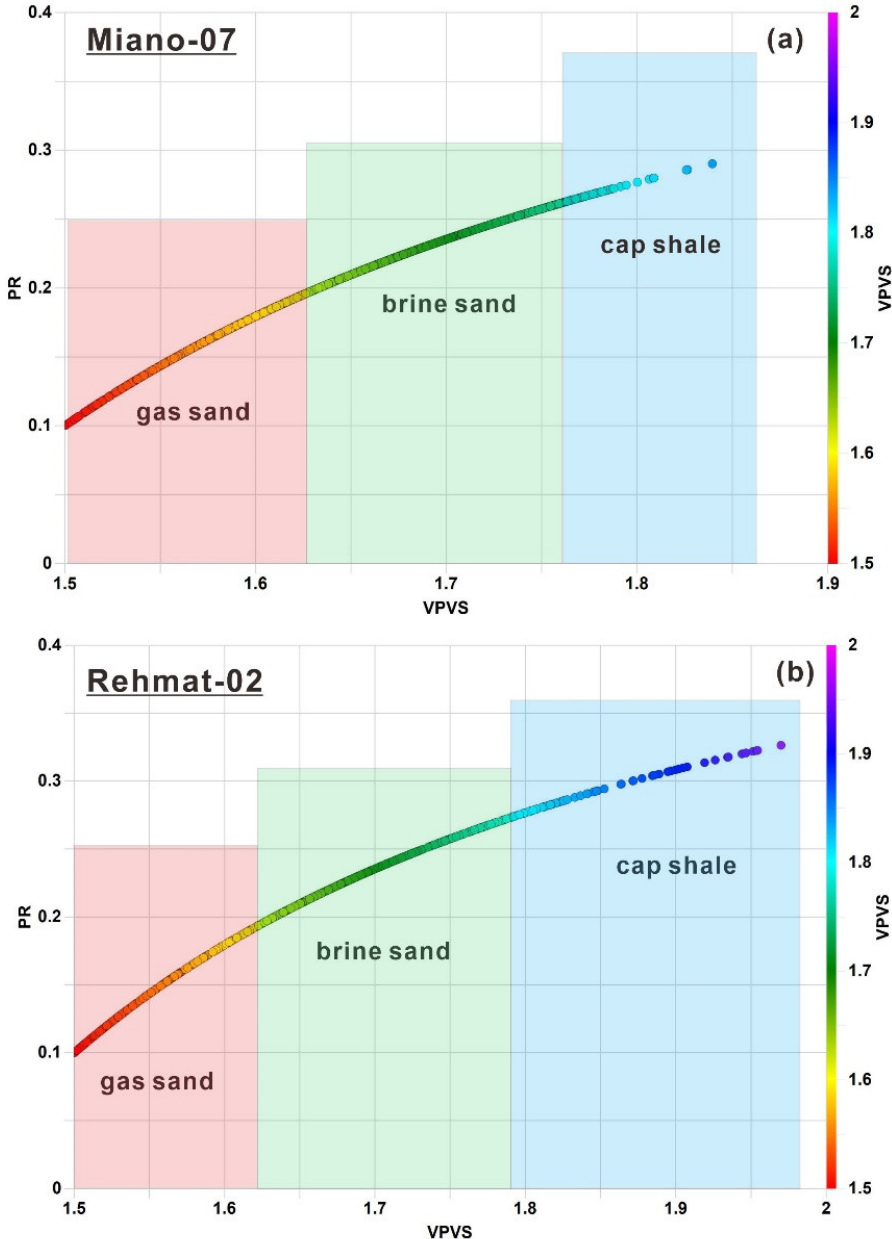
Figure 13. The RPT across PR versus AI of ( a ) Miano-01 and ( b ) Rehmat-02 wells at the targeted intervals to showcase the gas-saturated (red box), brine sand (green box), and cap shale (blue box)